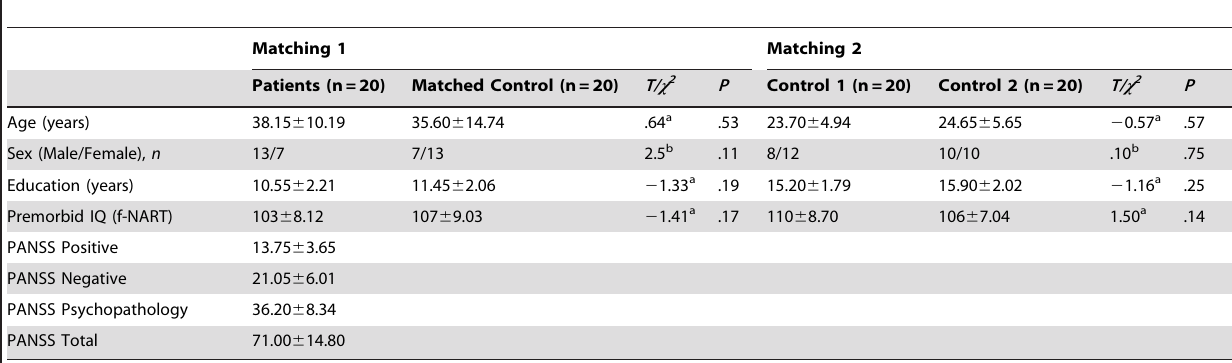
Table 1. Mean 6 standard deviation of demographic characteristics of